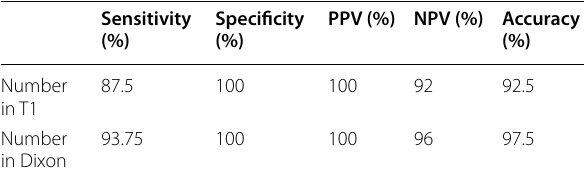
Table 3 Sensitivity and specificity for detecting